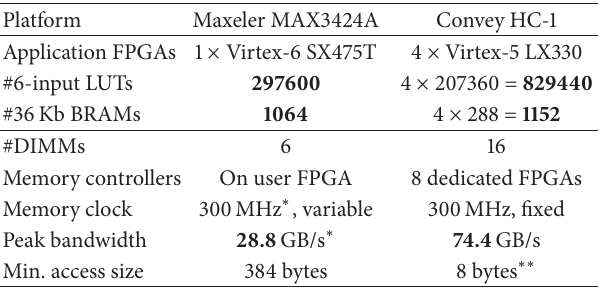
Table 1: Hardware resources of the two FPGA platforms as used in our experiments. ∗ Maxeler MAX3424A memory clock and band- width depend on user design. ∗∗ Convey HC-1 access granularity depends on installed